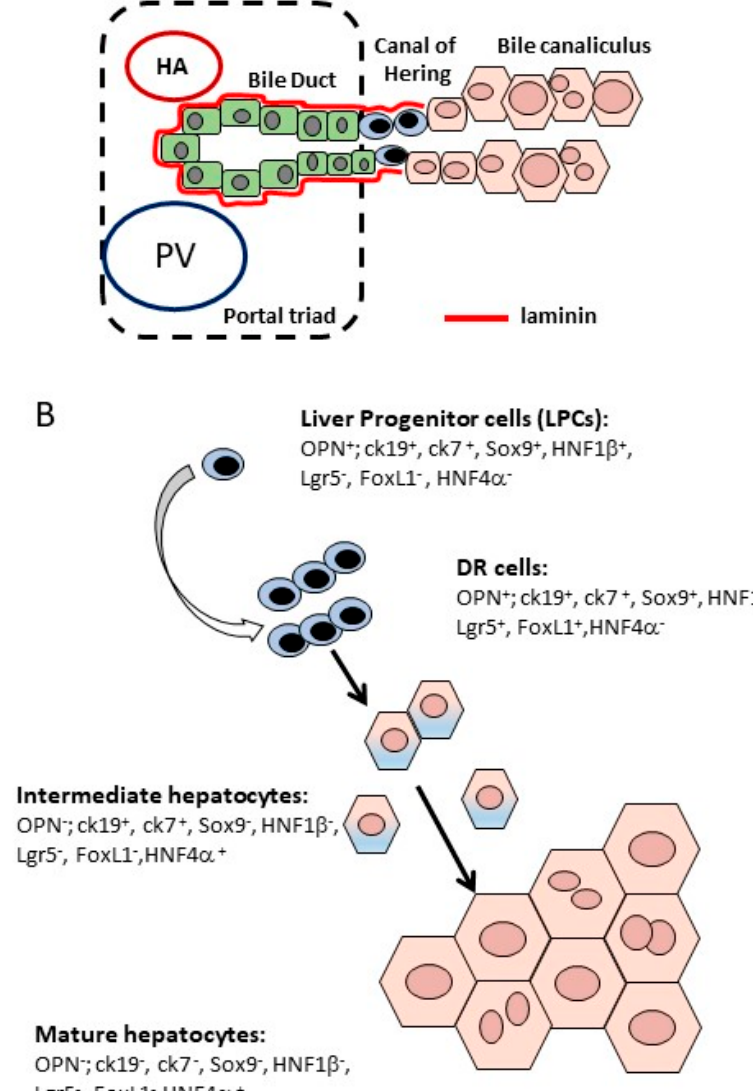
Figure 2. The liver progenitor cells (LPCs) and ductular reaction (DR). ( A ) Localization of LPCs within the liver; ( B ) dynamics of the differentiation process of DR cells: During injury, DR starts to emerge; DR cells will differentiate into hepatocytes through intermediate steps.